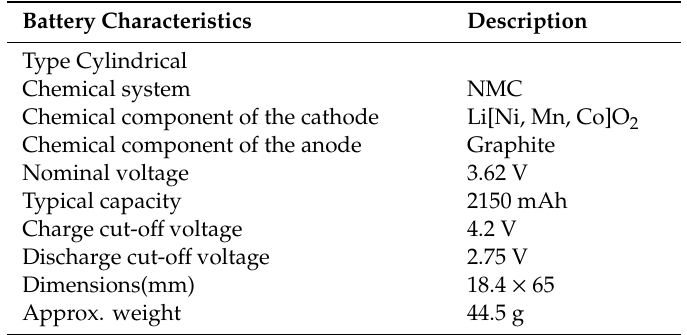
Table 1. Samsung 18,650 battery specification provided by the manufacturer [22].